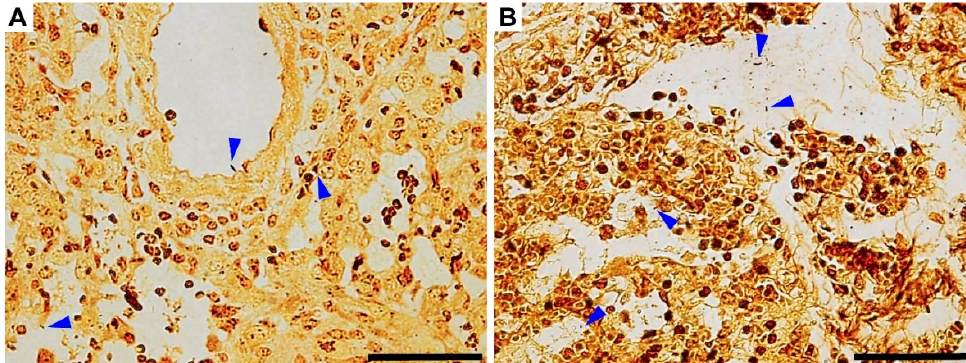
Figure 8. Bacterial visualization within the lungs of specific pathogen-free A/JOlaHsd mice infected with a high L. pneumophila dose. Rod-shaped structures, presumably L. pneumophila, were revealed (blue arrowheads). ( A , B ) Warthin–Starry silver stain for bacterial cells, appearing dark brown to black, as obtained at 5 dpi. ( B ) Postmortem examination (5 dpi) of a dead mouse; note the fibrin fibers within the lung parenchyma. Scale bars: 50 μ m.